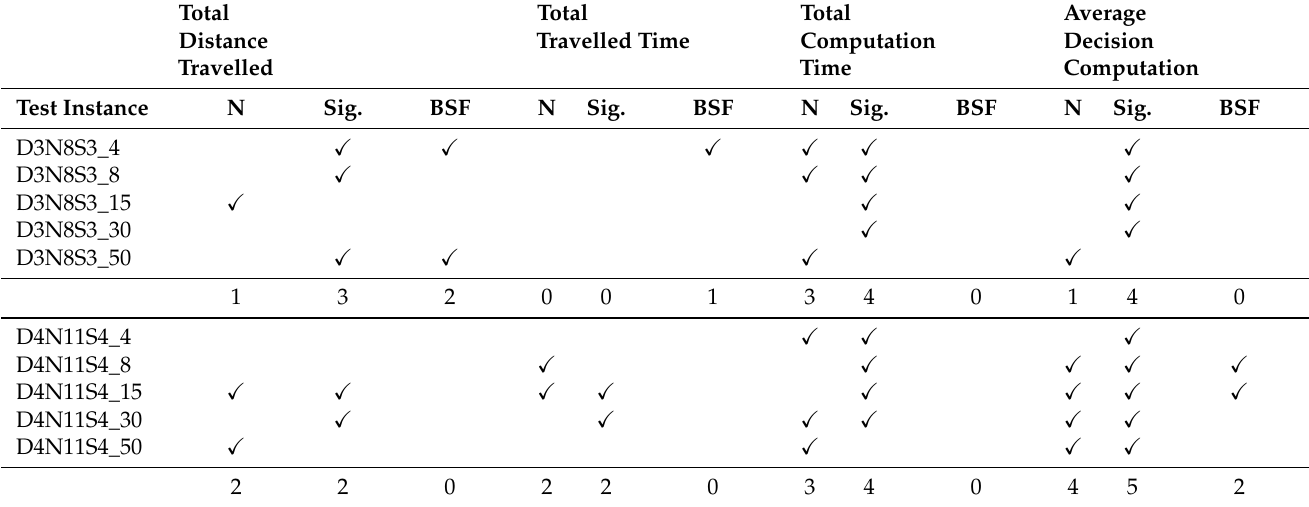
Table A2. PDS_RA performance with TBIH-1 application as base